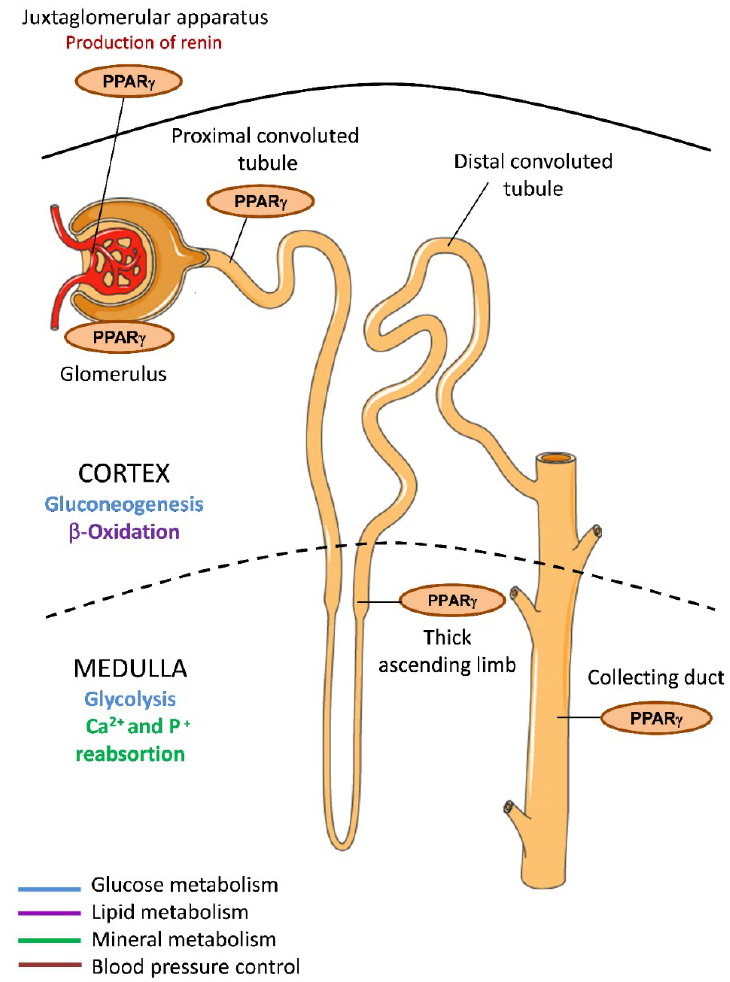
Figure 1. PPARγ expression in the kidney and implications for metabolism. PPARγ is expressed in different areas of kidney including the cortex and the medulla, which have different metabolic specializations. Glucose metabolism (blue); Lipid metabolism (purple); Mineral metabolism (green); Blood pressure control (red).